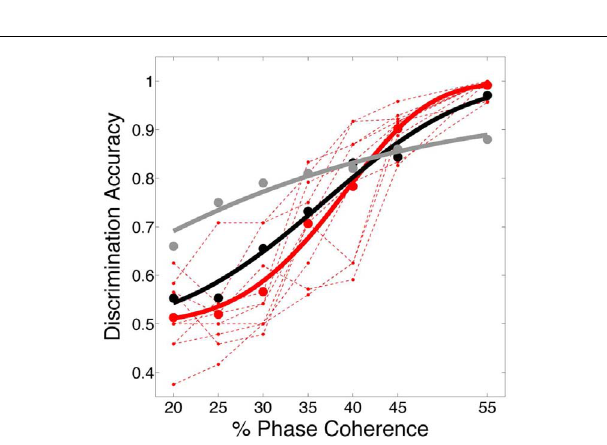
size N neurons by 10 time bins, each time bin being 25ms wide. Numbers indicate spike counts for bins with at least one spike. (C) A word represented as a vector of length N , computed using a single bin of size 250ms.